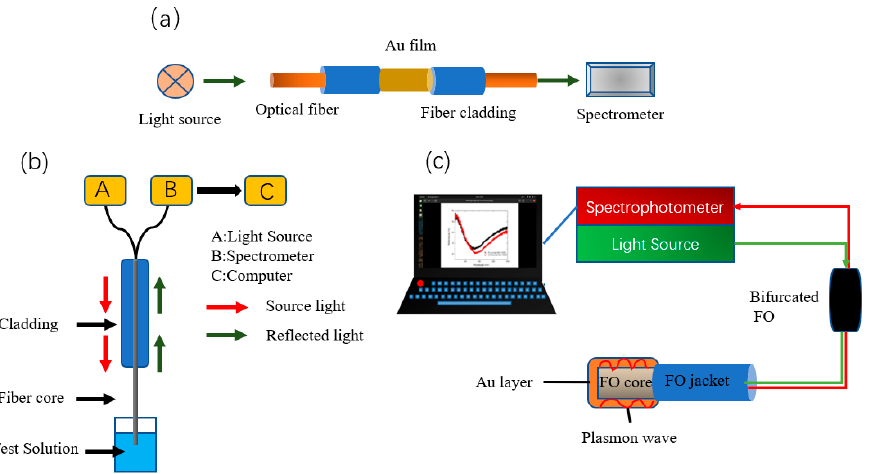
Figure 4. ( a ) Fiber optic SPR sensor detection equipment and process [67], ( b ) Schematic of the experimental setup used for the characterization of the AuNP coated fiber [68], and ( c ) Schematic diagram of the portable FO-SPR sensing system [69].